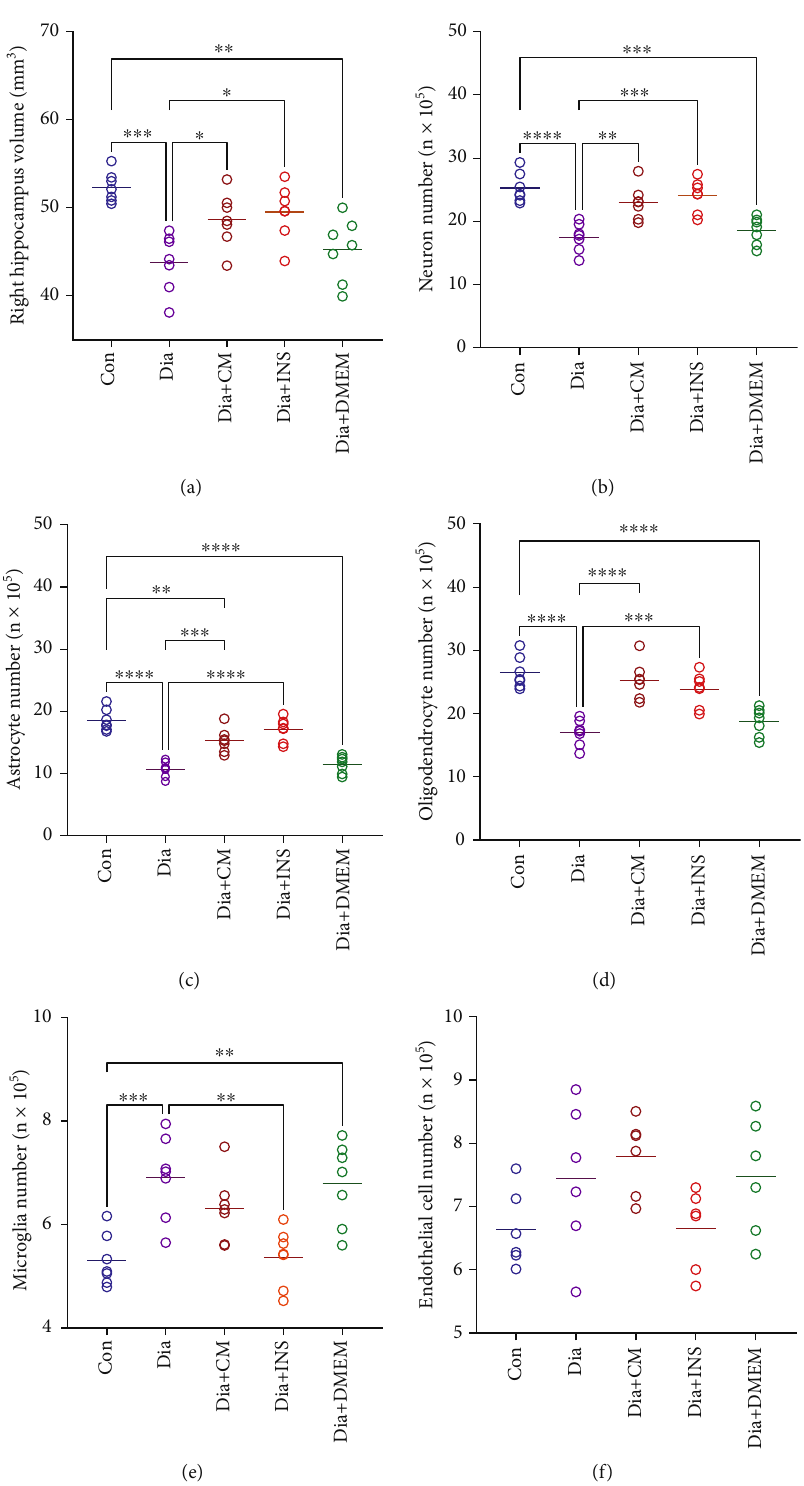
Figure 9: E ff ects of WJMSC-CM and insulin on the volume (a) and numbers of neurons (b), astrocytes (c), oligodendrocytes (d), microglia (e), and endothelial cells (f) of the hippocampus. The values are presented as mean ± SEM ( n = 7 ). ∗ P < 0 : 05 , ∗∗ P < 0 : 01 , ∗∗∗ P < 0 : 001 , and ∗∗∗∗ P < 0 : 0001 . Con: control; Dia: diabetes; Dia +CM: WJMSC-CM-treated diabetic group; Dia + INS: insulin-treated diabetic group; Dia +DMEM: DMEM-treated diabetic